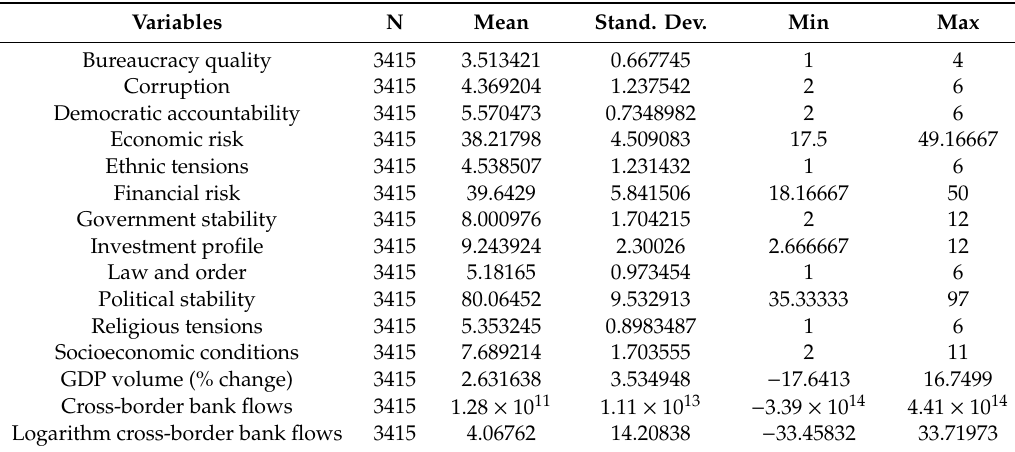
Table A2. Descriptive statistics—OECD countries.